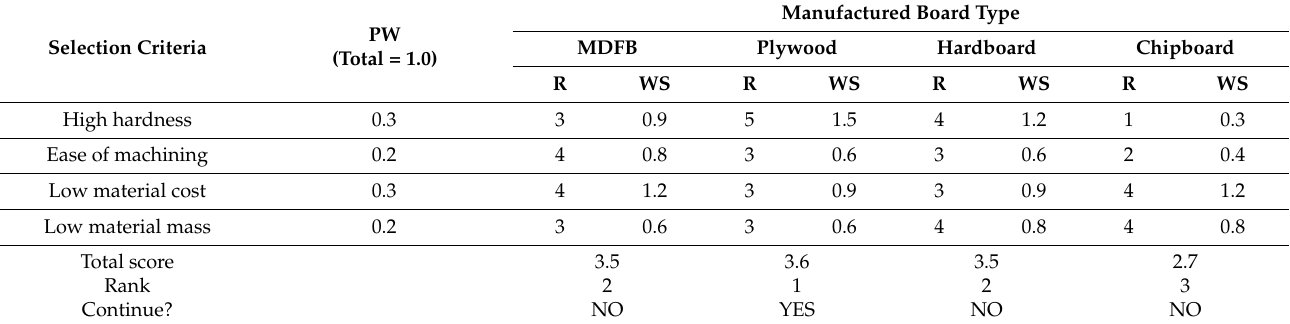
Table 19. Scoring of different manufactured board